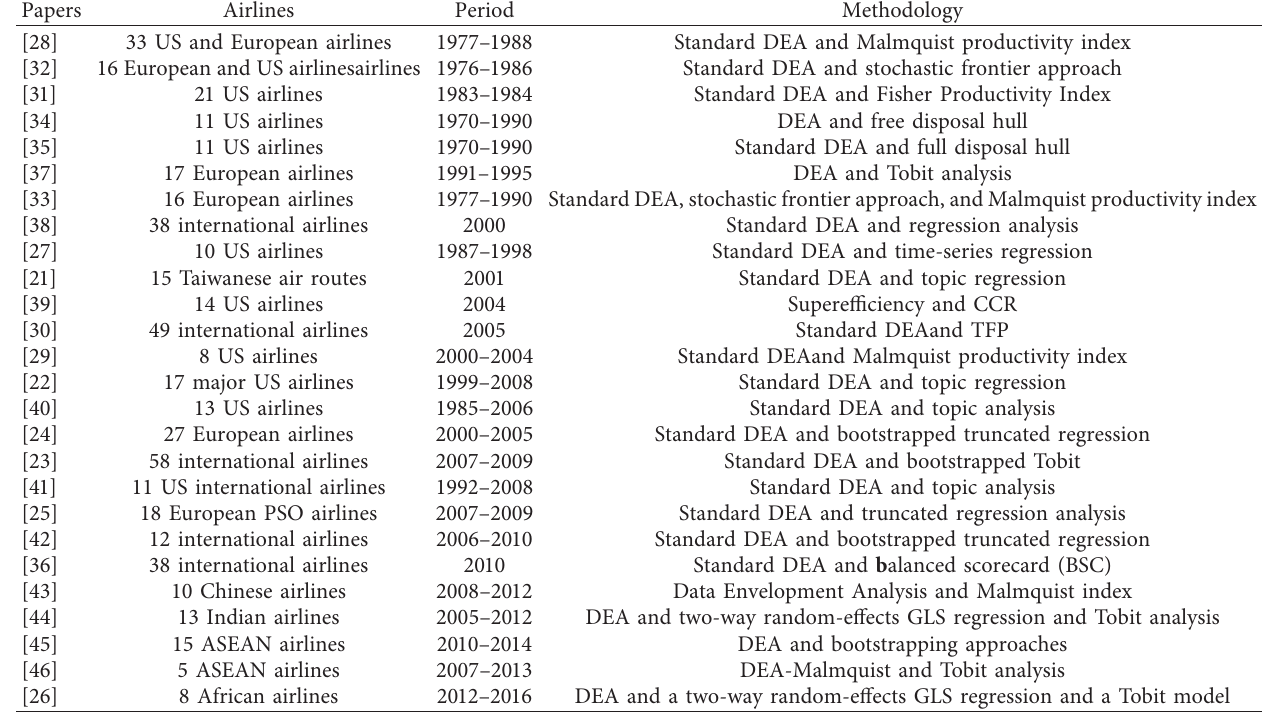
Table 2: Application of standard DEA combined with other methods in airline efficiency.